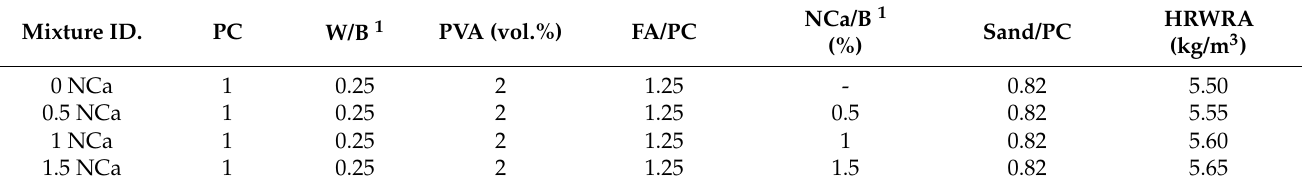
Table 3. Mixture ratios of nanocalcite-doped ECC